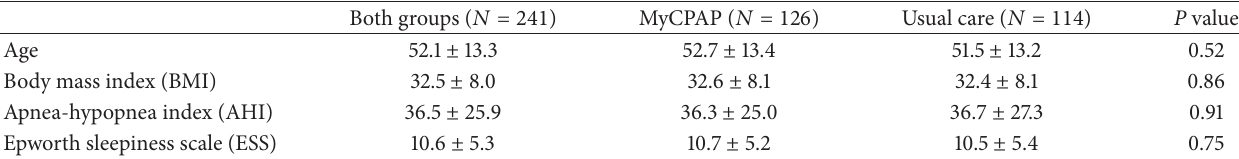
Table 2: Baseline characteristics (Mean ±